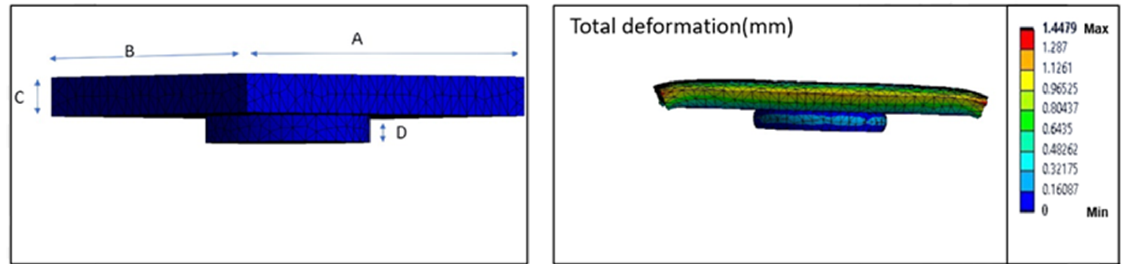
Figure 3. Silicon rubber substrate and its total displacement(deformation) under maximum force (10 Ib based on the weight of the heaviest dumbbell). Results of the FEM are as follows: ( A ) 6 cm,